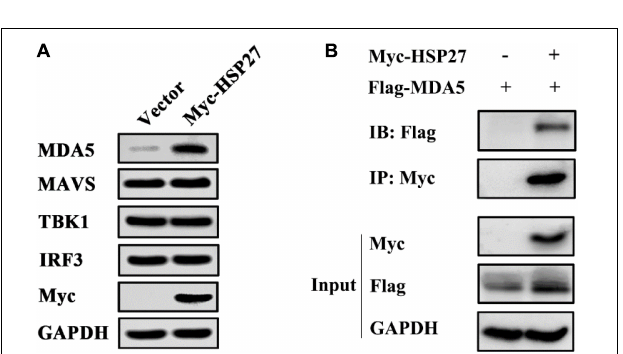
FIGURE 7 | HSP27 directly interacts with melanoma differentiation-associated gene 5 (MDA5) and stabilizes MDA5 expression. (A) A549 cells were transfected with pCMV-Myc or Myc-HSP27 (0.75 µ g) for 24 h. The protein expression of endogenous MDA5, MAVS, TBK1, IRF3, and Myc were evaluated by immunoblotting. GAPDH was used as a loading control. (B) A549 cells were co-transfected with Flag-MDA5 together with either pCMV-Myc or Myc-HSP27 for 36 h before performing co-immunoprecipitation (Co-IP) and immunoblotting with anti-Myc antibody. The protein expression of HSP27 and MDA5 were analyzed by immunoblotting. GAPDH was used as a loading